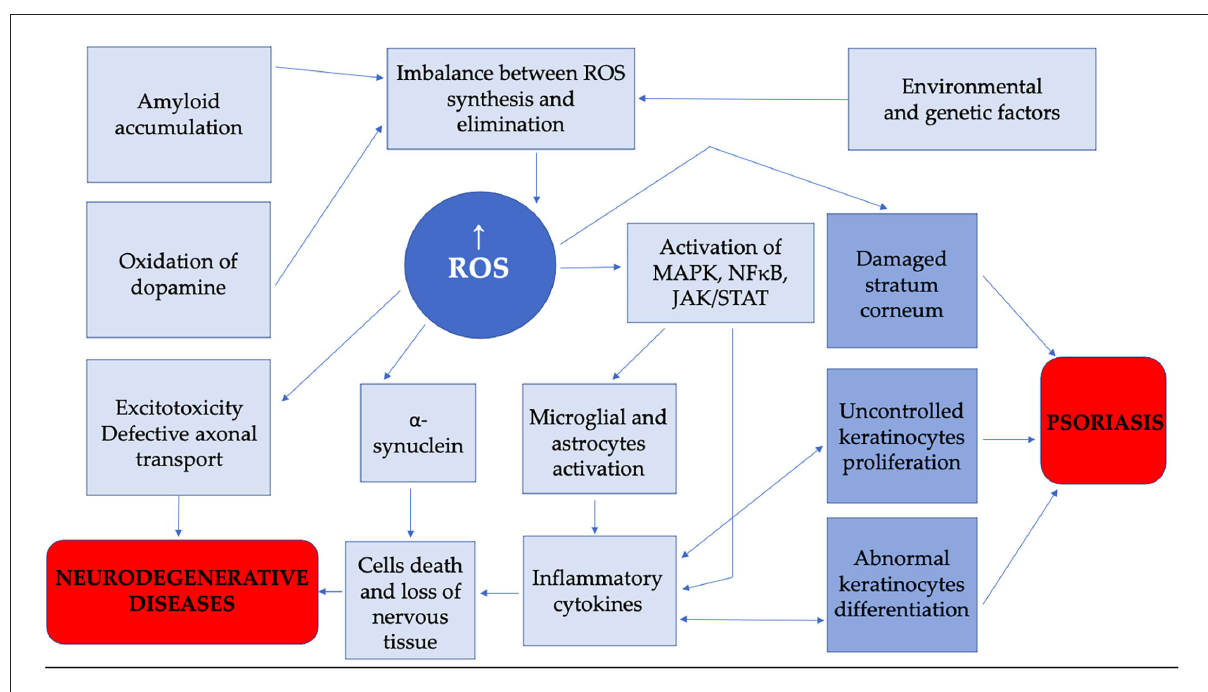
FIGURE2 The role of oxidative stress in pathogenesis of psoriasis and neurodegenerative diseases.